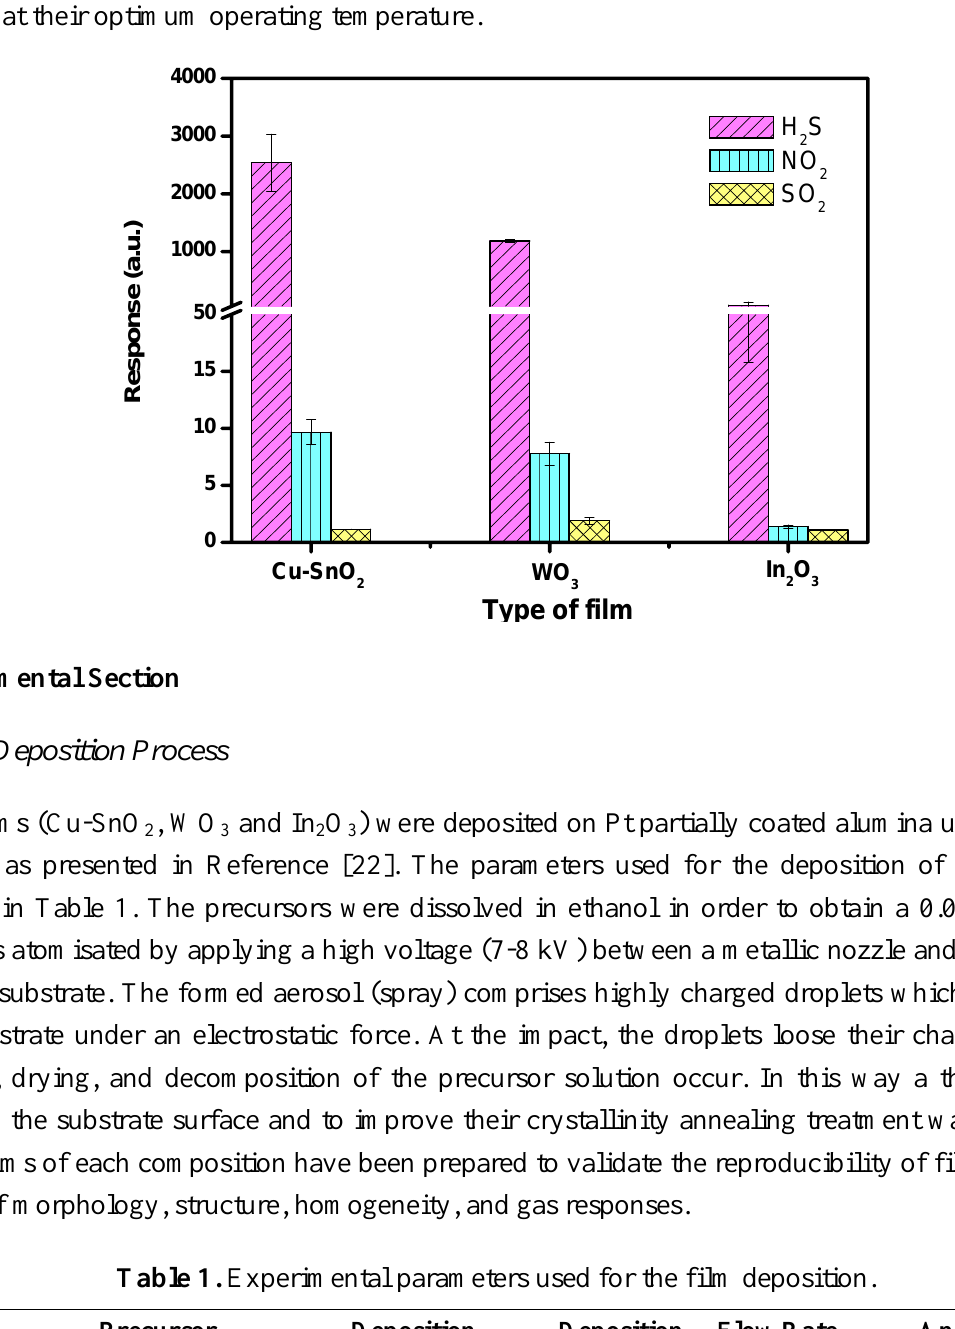
, WO and In O to 10 ppm H 2 3 2 3